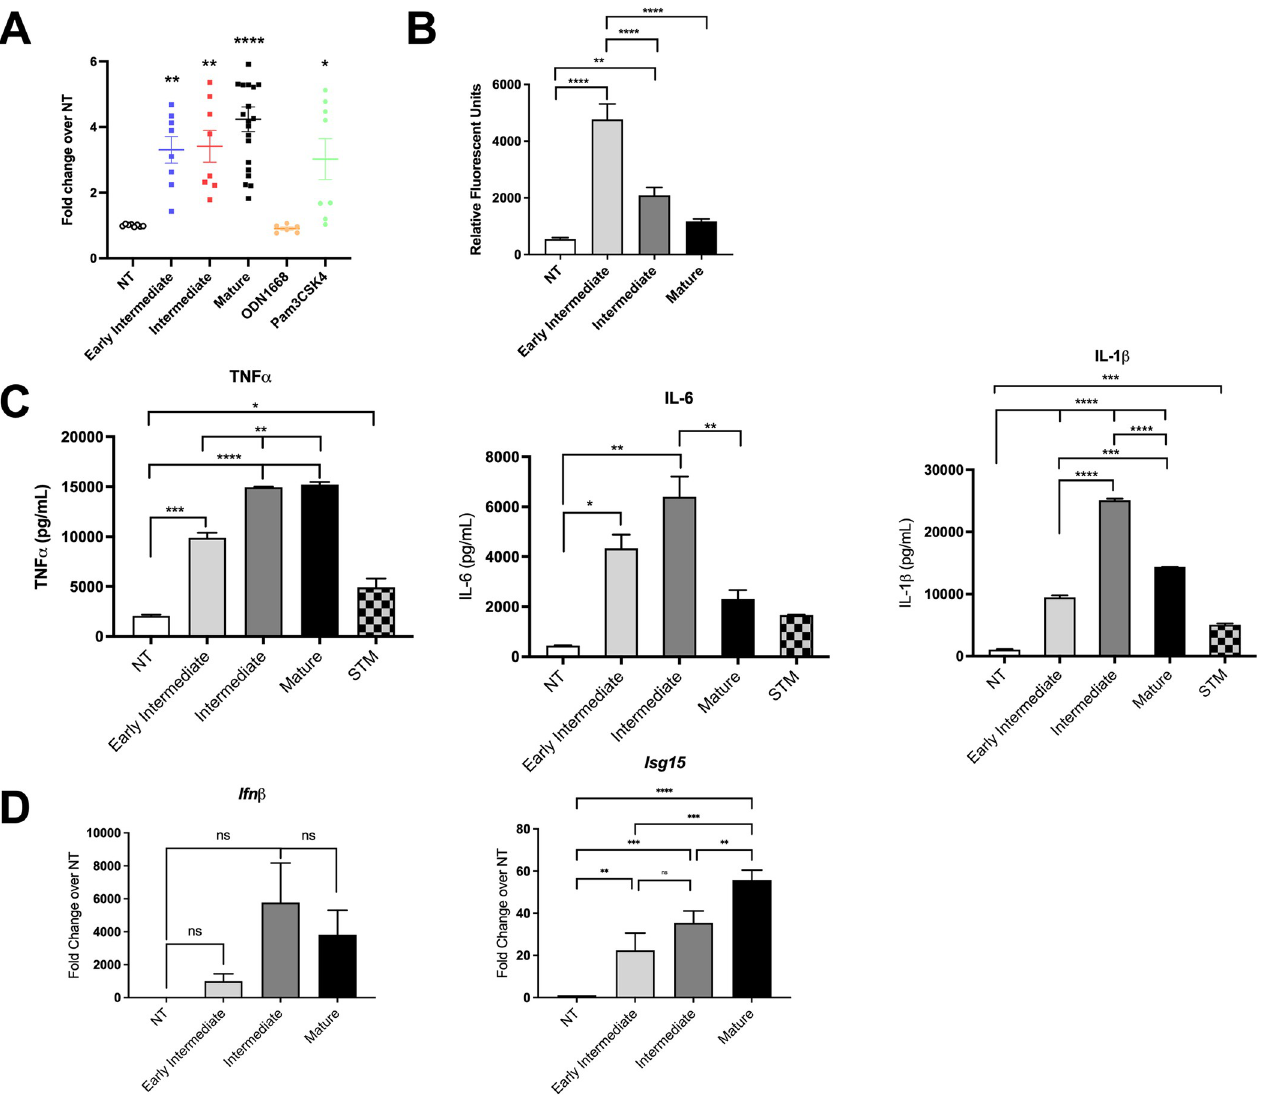
Fig 4. Curli preparations activate innate immune cells. (A) HEK293 Blue mTLR2 reporter cells (5x10 4 cells/well) were treated with 10 μ g/mL curli preparations, with CpG DNA (3 μ g/mL) as a negative control, or with Pam 3 CSK 4 (100 ng/mL) as a positive control. Absorbance at 620 nm was normalized to untreated (NT) control cells. Shown are data from four repeated experiments with whiskers showing SEM. Statistics were determined by ANOVA with Dunnett’s multiple comparisons post-test. � , P < 0.05; �� , P < 0.01; ���� , P < 0.0001. (B) Wild-type BMDMs (5x10 5 cells/well) were incubated with Congo Red- labeled curli preparations (10 μ g/mL) and internalization was quantified by monitoring fluorescence relative to untreated (NT) control cells. Results are shown for four repeated experiments with SEM. Statistics were determined by ANOVA with Tukey’s post-hoc test. �� , P < 0.01; ���� , P < 0.0001. (C) Wild-type BMDMs (5x10 5 cells/well) were stimulated with 10 μ g of curli preparations or with S . Typhimurium (STM) grown in inflammasome inducing conditions at an MOI of 1:20 as a positive control or left untreated (NT) for 4 (IL-6 and TNF α ) or 24 (IL-1 β ) hours. Production of TNF α (left), IL-6 (middle), and IL-1 β (right) were quantified by ELISA in the supernatants. Means ( ± SEM) are shown. One representative experiment of three independent experiments is shown. (D) Wild-type BMDMs (5x10 5 cells/well) were stimulated with 2.5 μ g/mL of curli preparations or 3 μ g/mL of CpG DNA or left untreated (NT). Expression of Ifn β and Isg15 was determined by